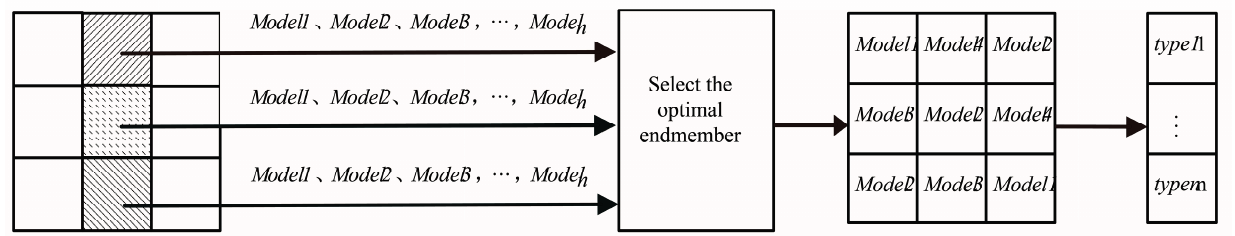
Figure 2. Multiple Endmember Spectral Mixture Analysis